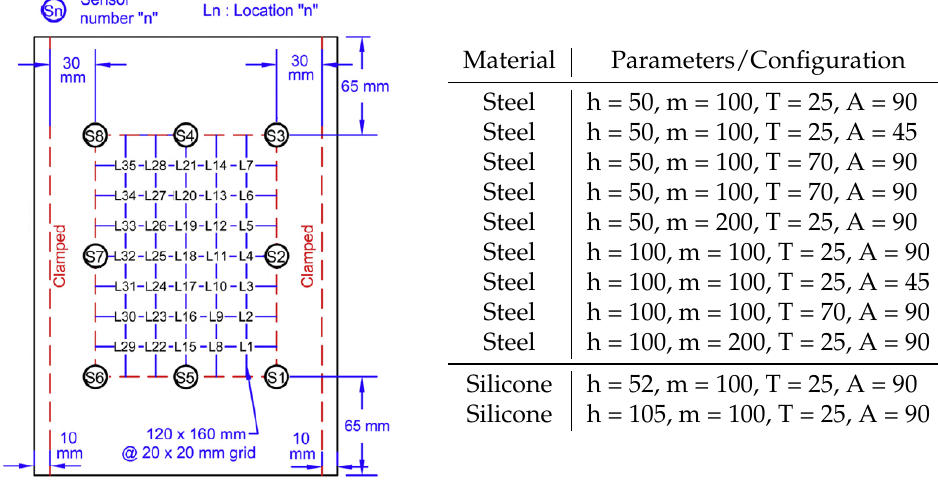
Figure 2. Layout of the plate tests with the sensor and impact locations. The figure is a modified ver- sion of Figure 2 in [11]. The table gives information about the configurations for the performed